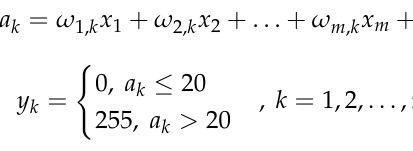
Figure 2. An example of WSNs. The first layer outputs S J [ ∅ ] x , where ∅ represents an empty set and operates U λ the original signal x . Then, the second layer outputs S J [ λ 1 ] x and operates U λ scattering procedure propagates iteratively to obtain all convolution